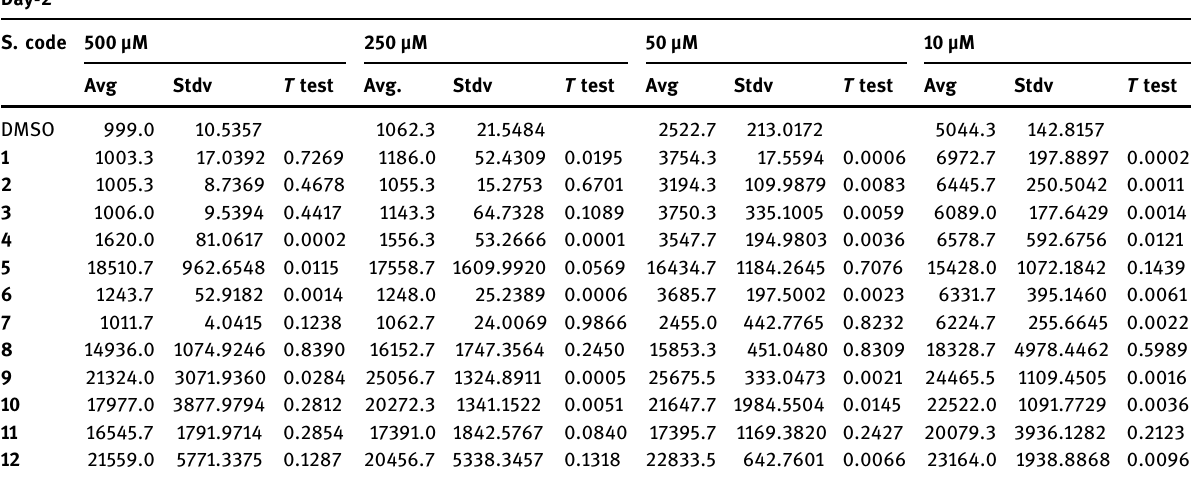
Table 2: Proliferation data for day 2